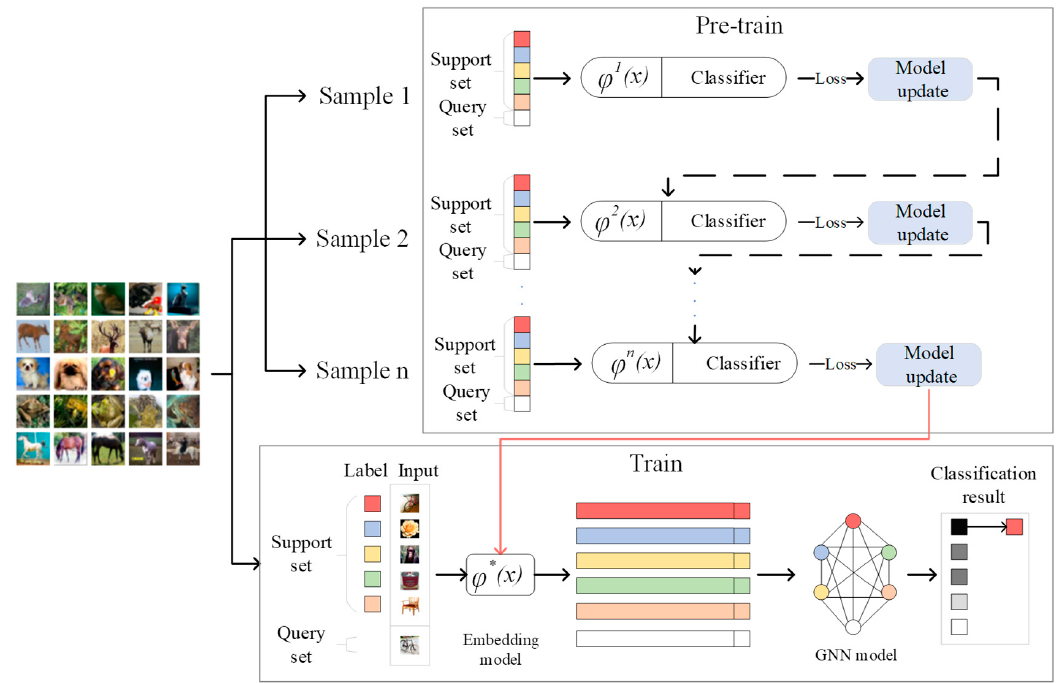
Figure 2. The whole process of the algorithm, including pre-training and formal training; φ(x) is the embedding model.